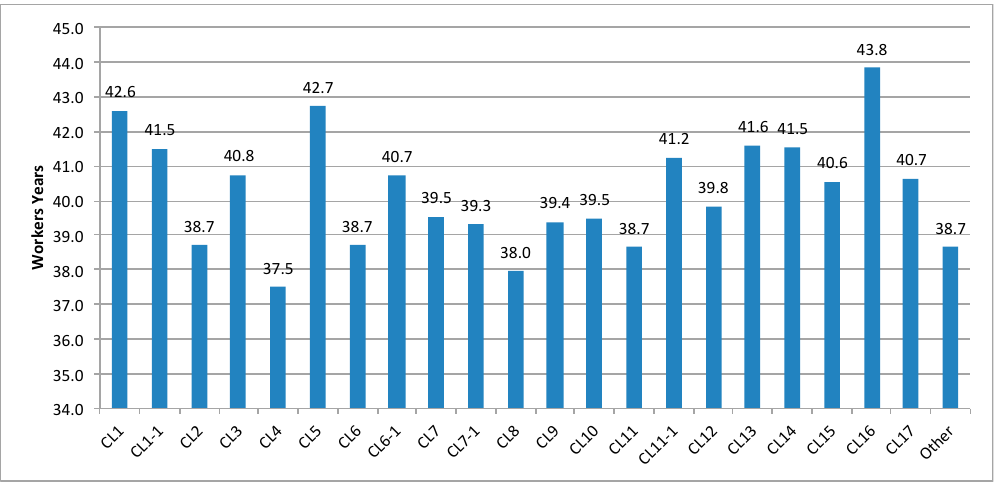
Figure 7. Average age of the workers of each cluster.